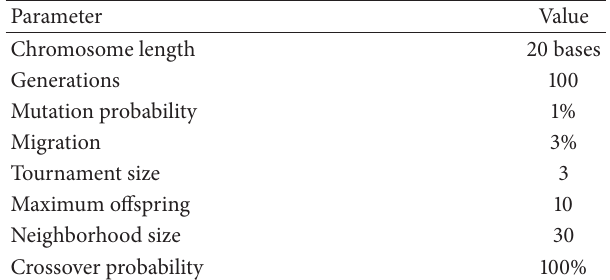
Table 1: Fixed parameters.